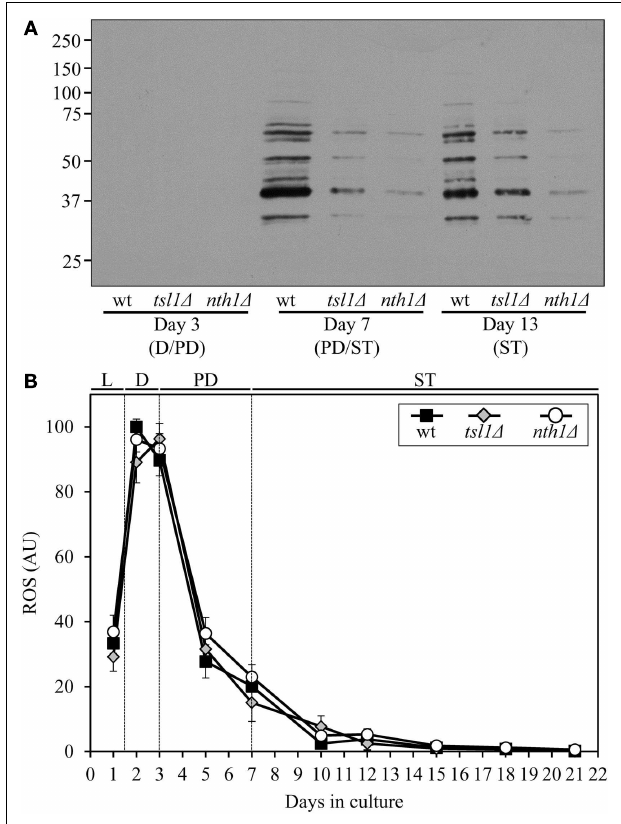
FIGURE 2 |Although mutations that in yeast grown under CR conditions increase trehalose concentration prior to entry into quiescence do not alter ROS levels, they reduce oxidative damage to cellular proteins throughout lifespan. (A) Immunodetection of carbonyl groups in oxidatively damaged cellular proteins in chronologically aging wt and mutant strains. (B) The dynamics of age-related changes in intracellular ROS levels during chronological aging of wt and mutant strains. wt, tsl1 ∆ and nth1 ∆ cells were cultured inYP medium initially containing 0.2% glucose. Data are presented as mean ± SEM ( n = 3–4). Abbreviations: D, diauxic growth phase; PD, post-diauxic growth phase; ST, stationary growth